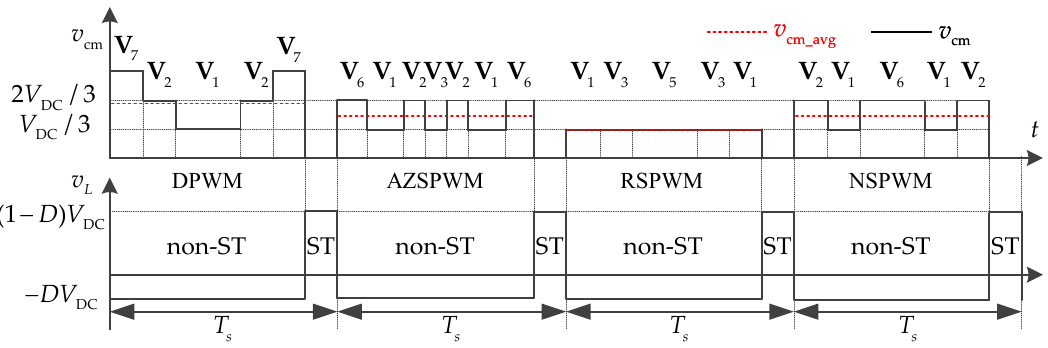
Figure 5. Proposed CMV reduction strategies with switching patterns and CMV when using DPWM, AZPWM, RSPWM and NSPWM strategies.